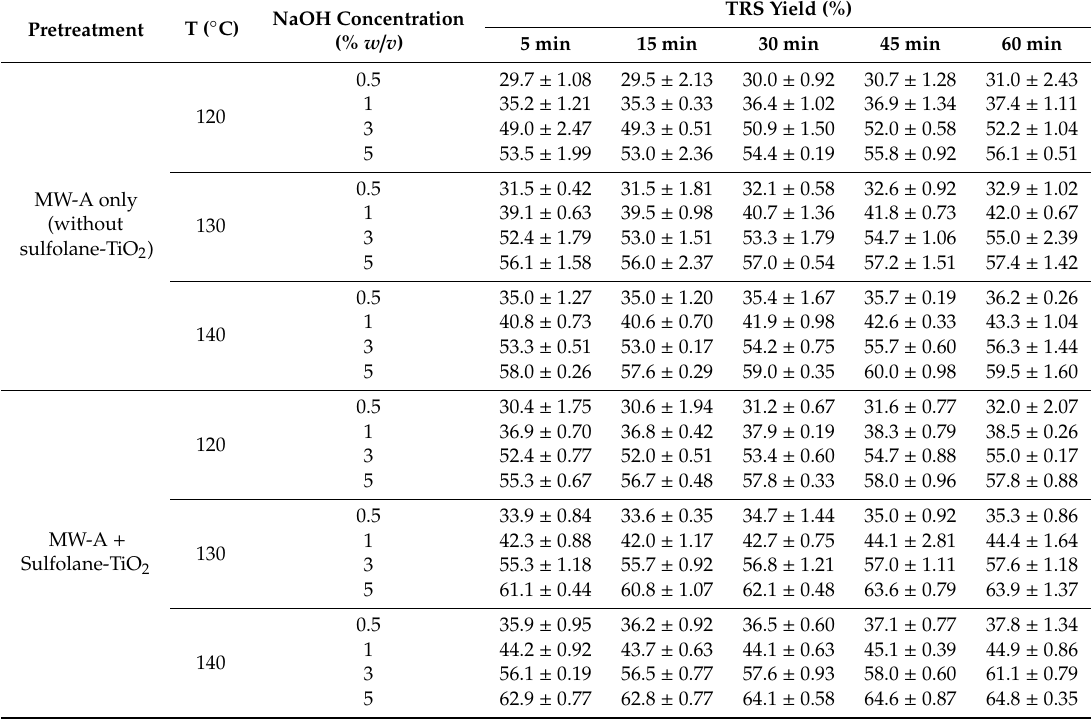
Table 1. Total reducing sugars (TRS) production from enzymatic hydrolysis of SCB for di ff erent temperatures, NaOH concentrations and reaction times, with and without sulfolane-TiO 2